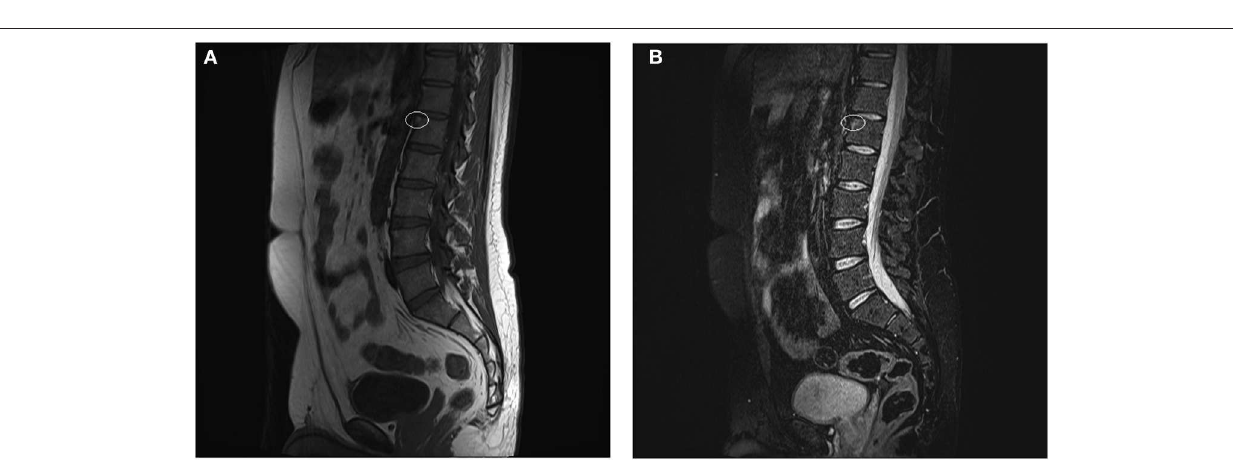
FIGURE 2 | (A,B) Anterior spondylitis. (A) hypointense signal at the anterior-superior corner of L1 (white ring) in sequence T1 (B) corresponding hyperintense signal at the anterior-superior corner of L1 in sequence STIR (white ring). The written informed consent was obtained from the individual for the publication of these